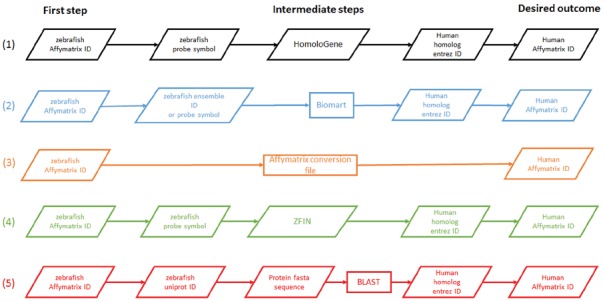
Mapping zebrafish to human sequences via five annotated resources. Sequence probes from Affymetrix’s GeneChip Zebrafish Genome Array were mapped to probes in GeneChip Human Genome U133A. Each mapping pipeline is based on a single resource independently: (1) HomoloGene (Wheeler et al., 2001; Acland et al., 2014), (2) Biomart (Kasprzyk, 2011), (3) conversion file provided by Affymetrix, (4) ZFIN (Bradford et al., 2011), and (5) BLAST homology searches performed at our laboratory (Altschul et al., 1990, 1997; Ye et al., 2006). In the latter method we focused on the most statistically significant BLAST match per query.